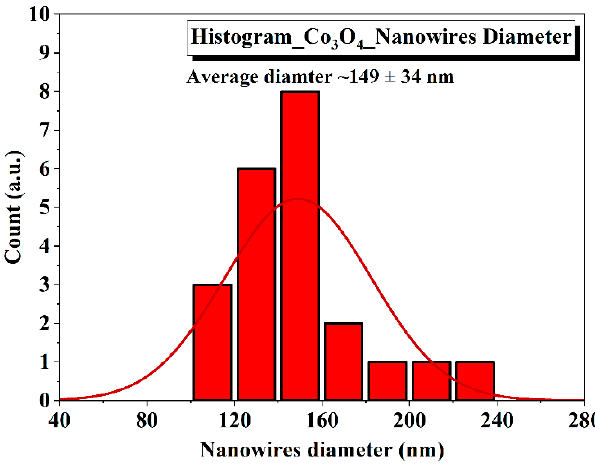
Figure 3. Histogram showing average diameter of Co 3 O 4 nanostructures.